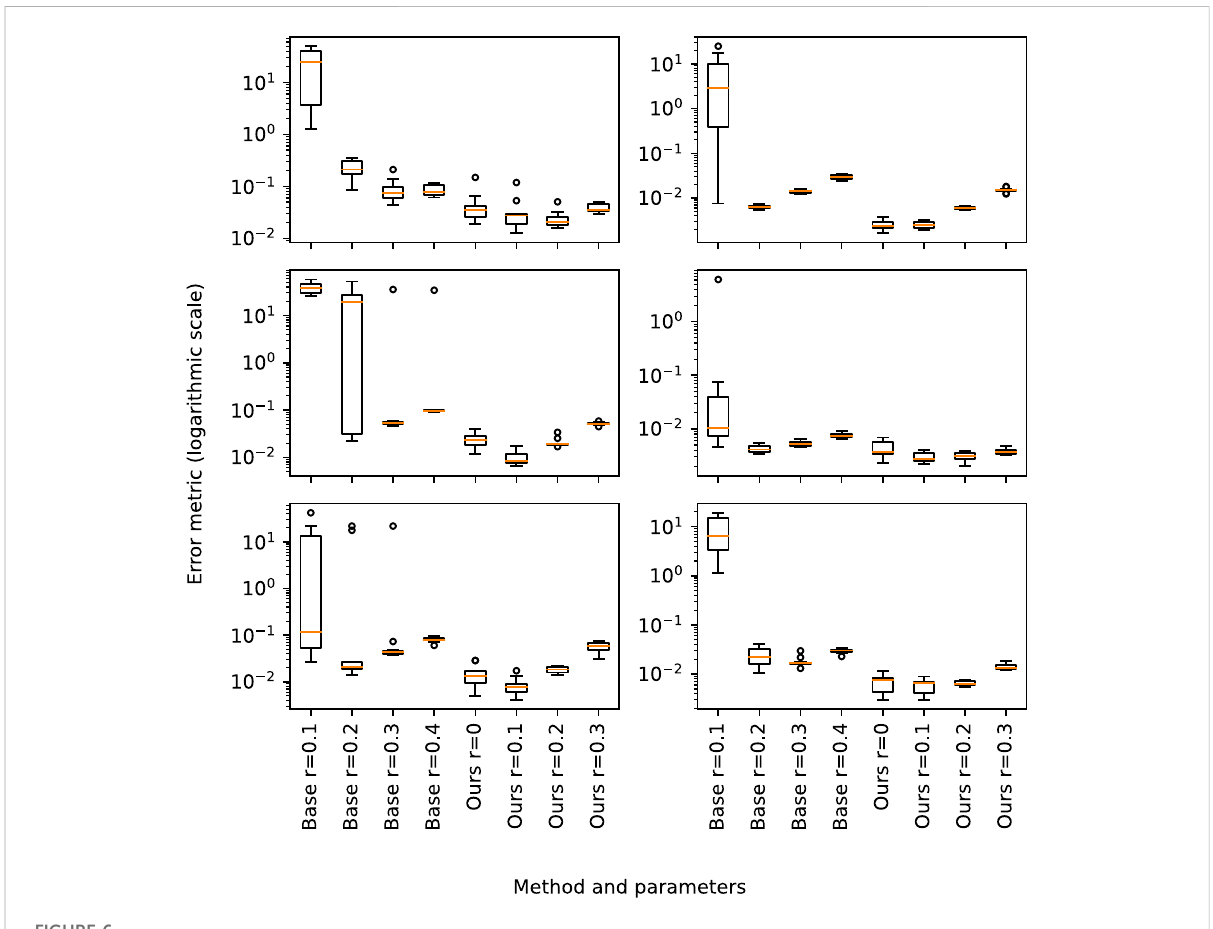
FIGURE 6 Graphical representation of the error shown in Table 2 for the set of tree specimens evaluated with the proposed